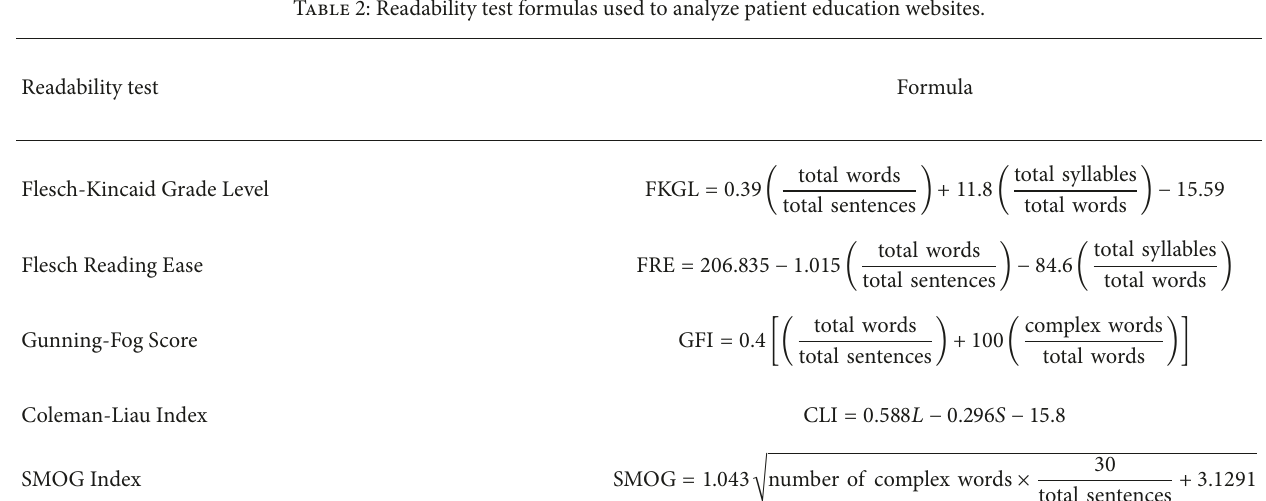
Table 2: Readability test formulas used to analyze patient education